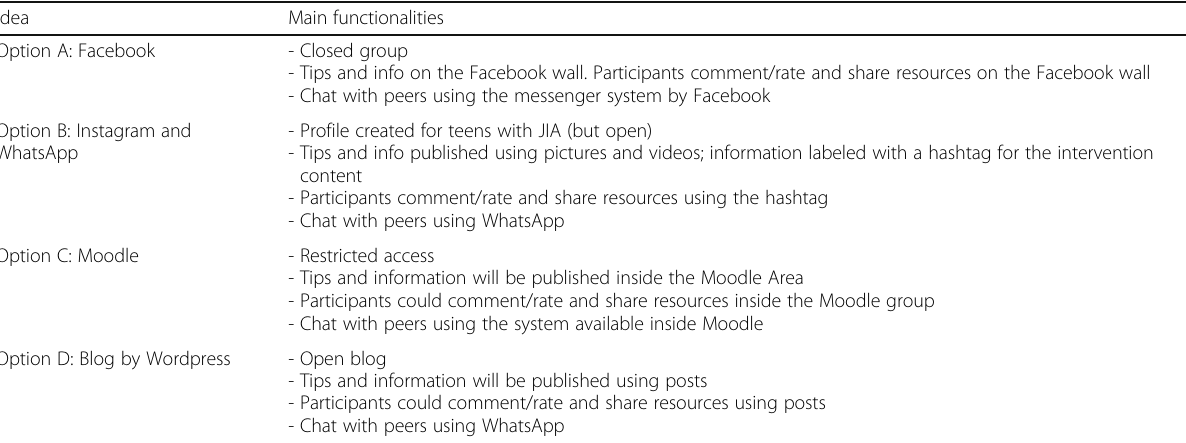
Table 2 Ideas for an online resource for children with JIA Idea